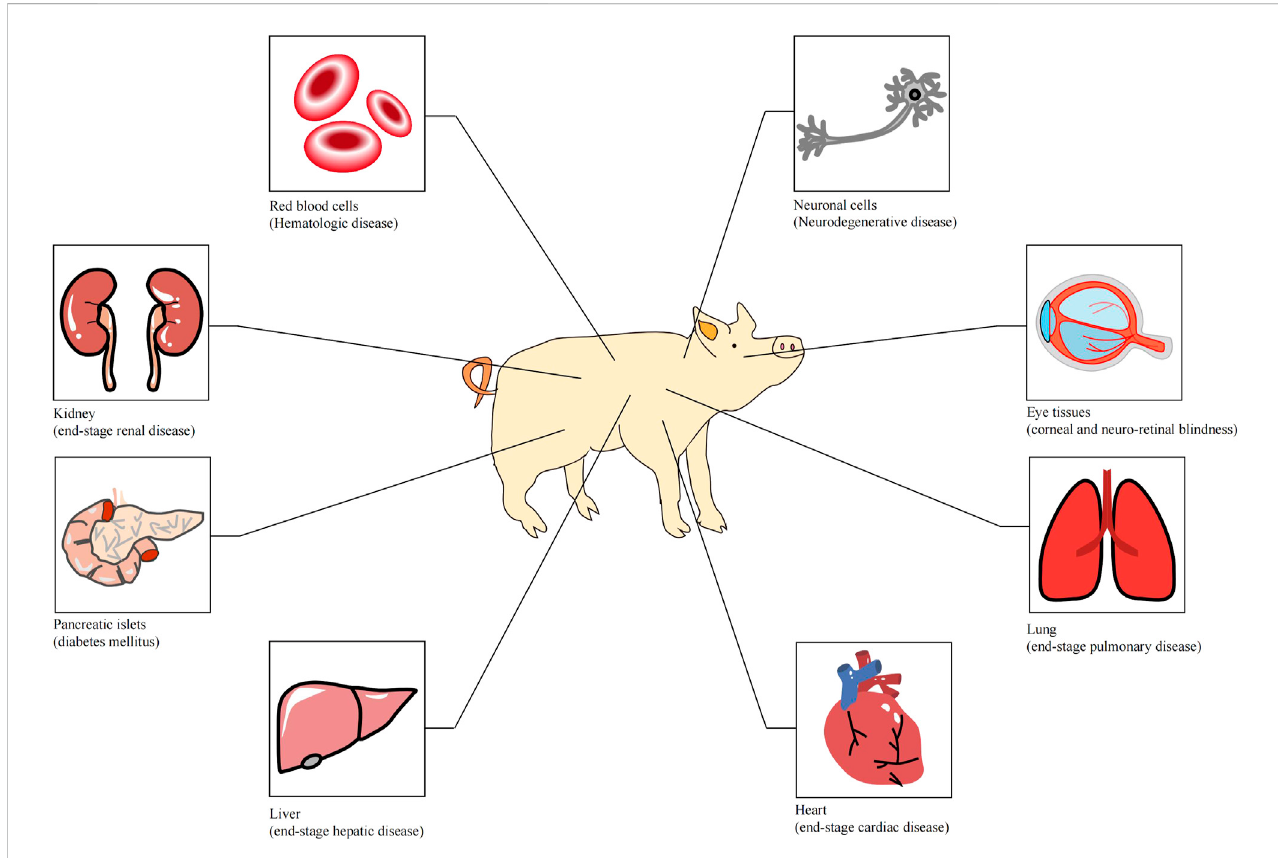
FIGURE 1 Tissues or organs that can be used for xenotransplantation (Ekser et al. 2012).